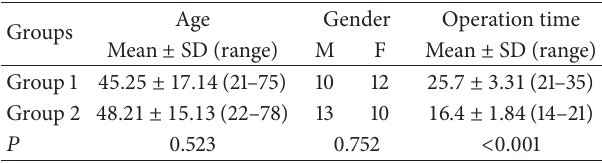
Table 1: Age, sex, and operation time values in the study groups. Age Gender Operation time Groups Mean ± SD